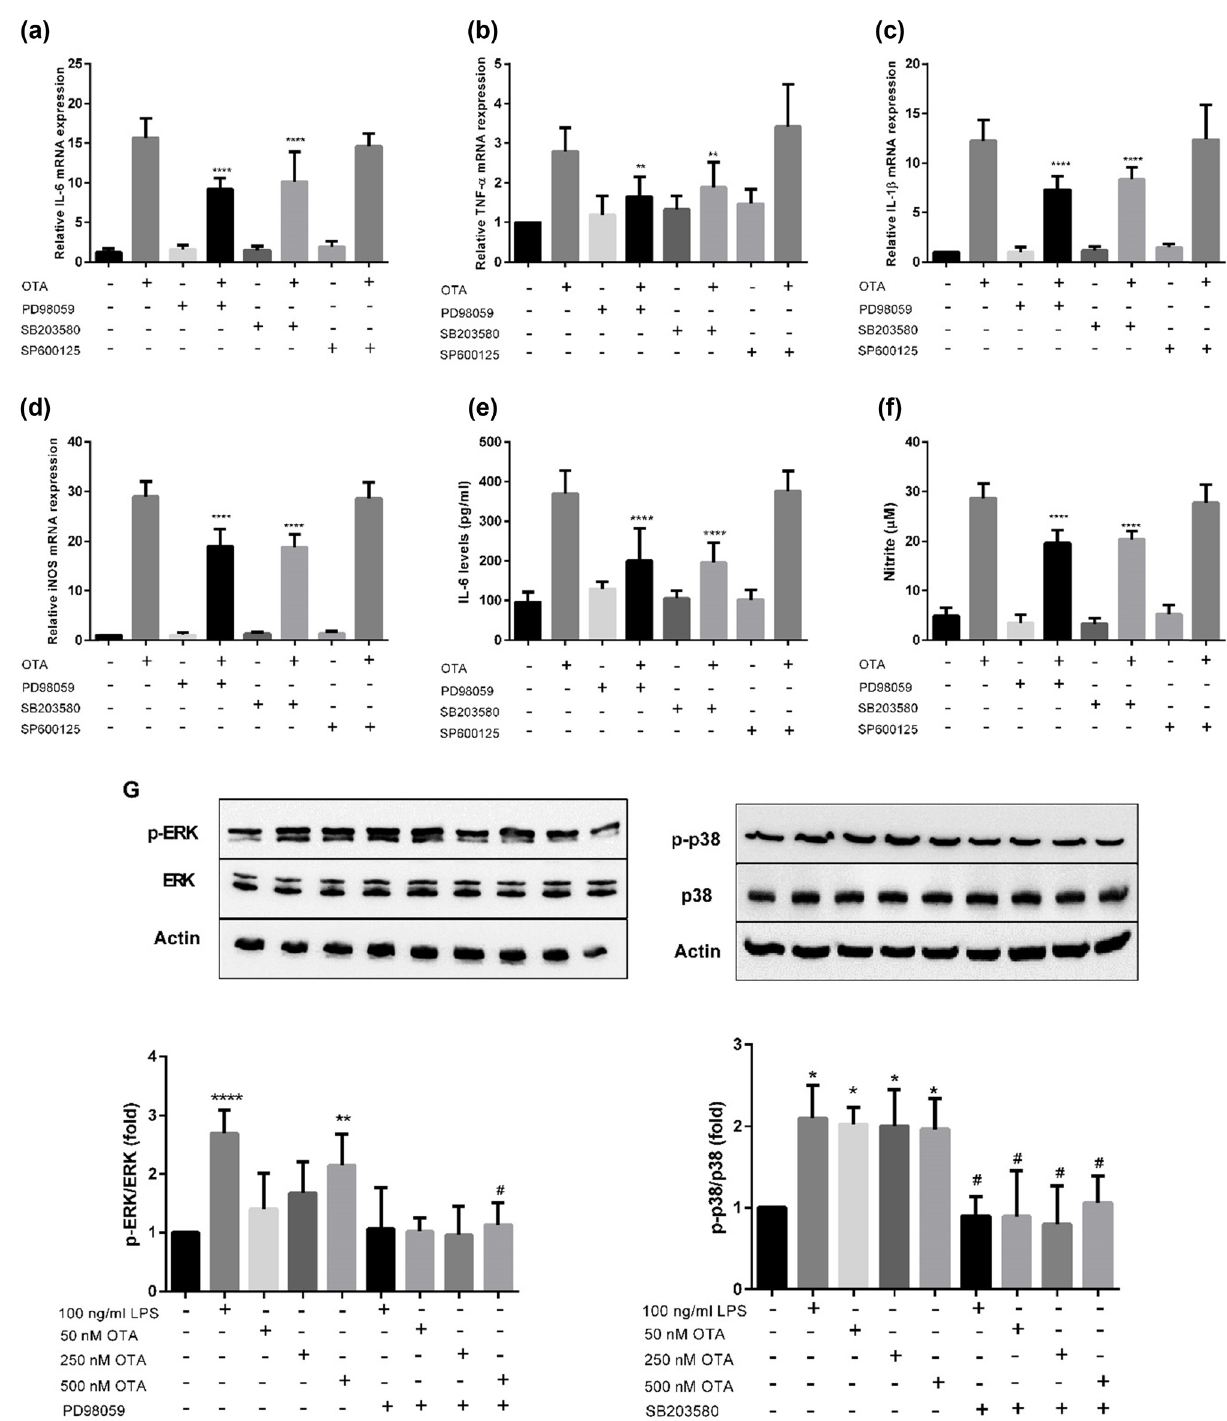
Figure 3: Involvement of MAP kinases in OTA - induced pro - in fl ammatory cytokine and iNOS expression in glial cells. BV - 2 cells were pre - treated with or without PD98059 ( 20 μ M ) , SP600125 ( 20 μ M ) , or SB203580 ( 10 μ M ) for 1 h, and then treated with OTA ( 500 nM ) for 24 h. ( a – d ) mRNA levels of IL - 6, TNF - α , IL - 1 β , and iNOS examined by real - time PCR. ( e ) IL - 6 levels detected by ELISA. ( f ) NO levels measured by Griess assay. ( g ) Phosphorylation levels of ERK and p38 MAPK determined by western blot analysis. Data were expressed as mean value ± SD of at least three independent experiments. * p < 0.05, ** p < 0.01, and **** p < 0.0001 compared to medium control and # p < 0.05 compared with